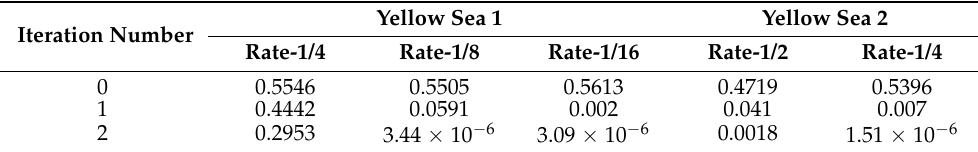
Table 3. Calculation of the mean aggregation degree ξ m for Yellow Sea 1 and Yellow Sea